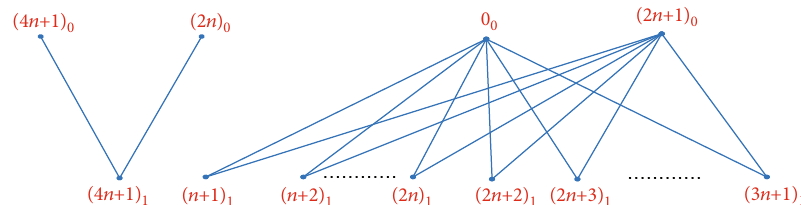
∪ C ∪ K . 1,1 6 1, n − 7